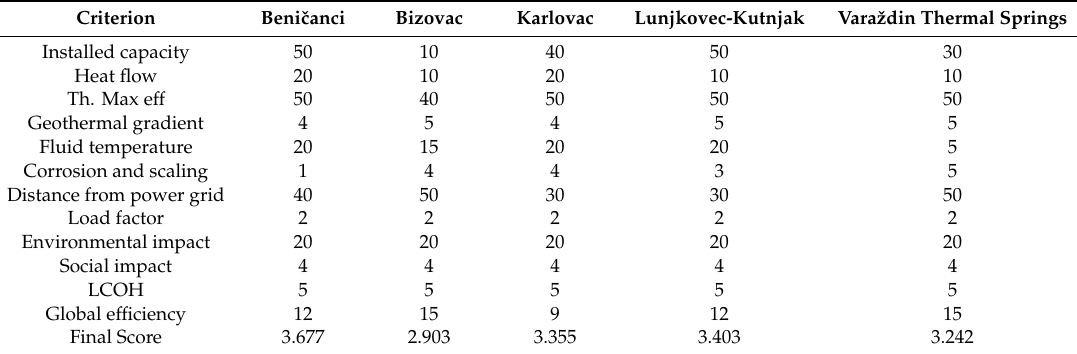
Table 9. Weighted scores for district heating